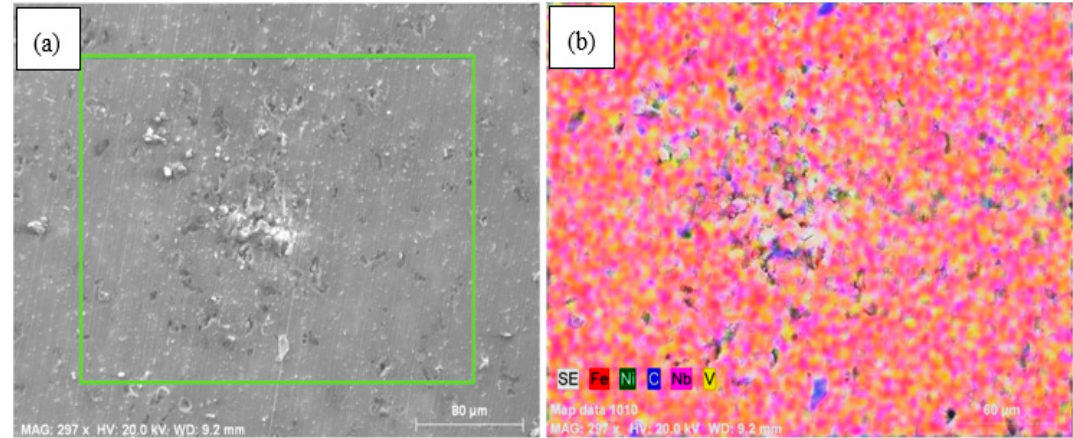
Figure 9. SEM images of the alloy 3-NbV-5Ni after corrosion ( a ) low and ( b ) high magnification.